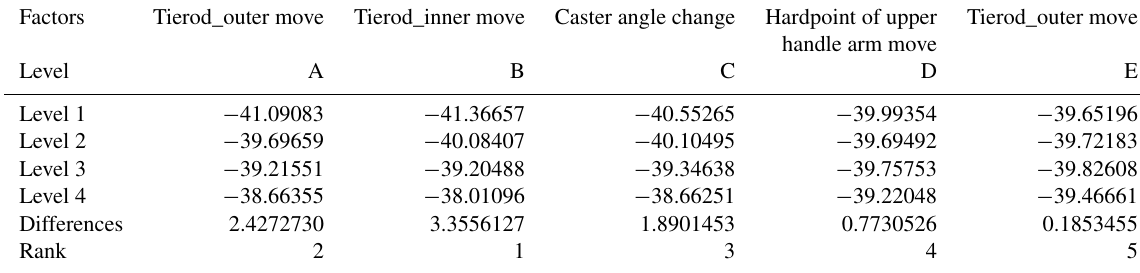
Table 8. SN ratio of the first-stage Taguchi